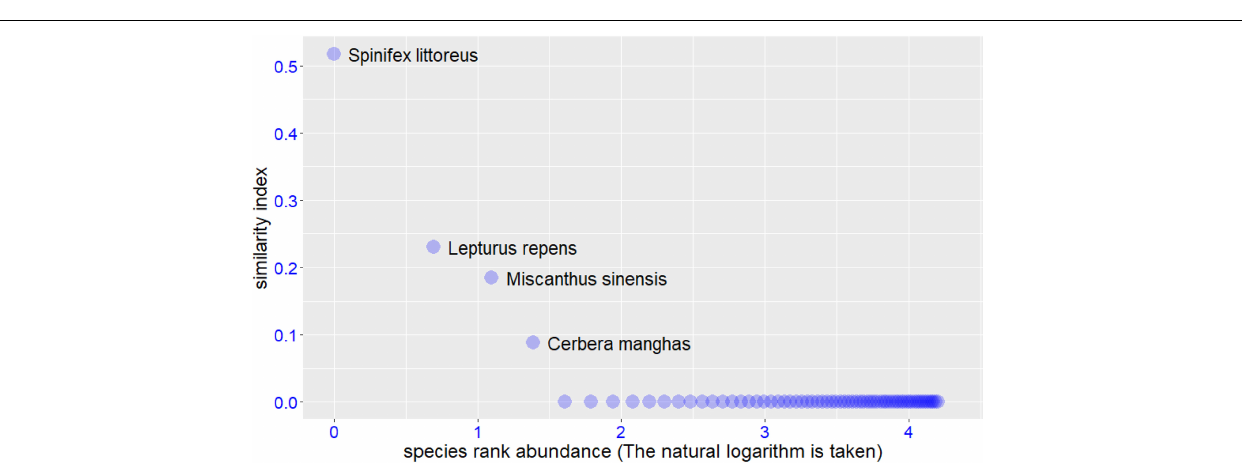
FIGURE 4 | Similar to figure 2, but the species selection results for the target species Cynodon dactylon ‘Yangjiang.’